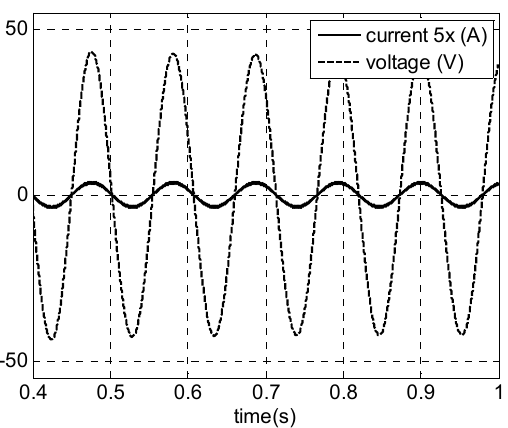
Figure 18. Simulations results for a PMSG. For v wind = 3 m/s: phase voltage and current.